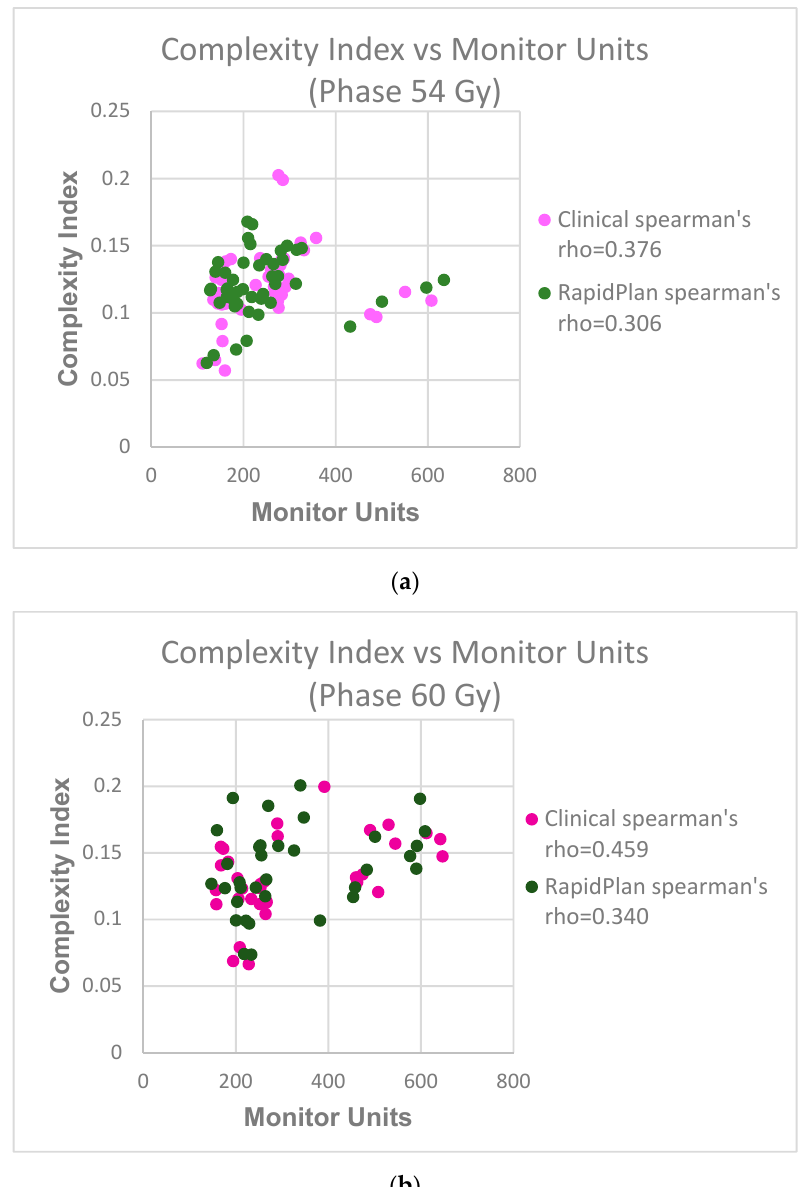
Figure 3. ( a ). Complexity index against monitor units for phase 54 Gy, and for clinical and RapidPlan™ plans in the open-loop validation set. ( b ) Complexity index against monitor units for phase 60 Gy for clinical and RapidPlan™ plans in the open-loop validation set.